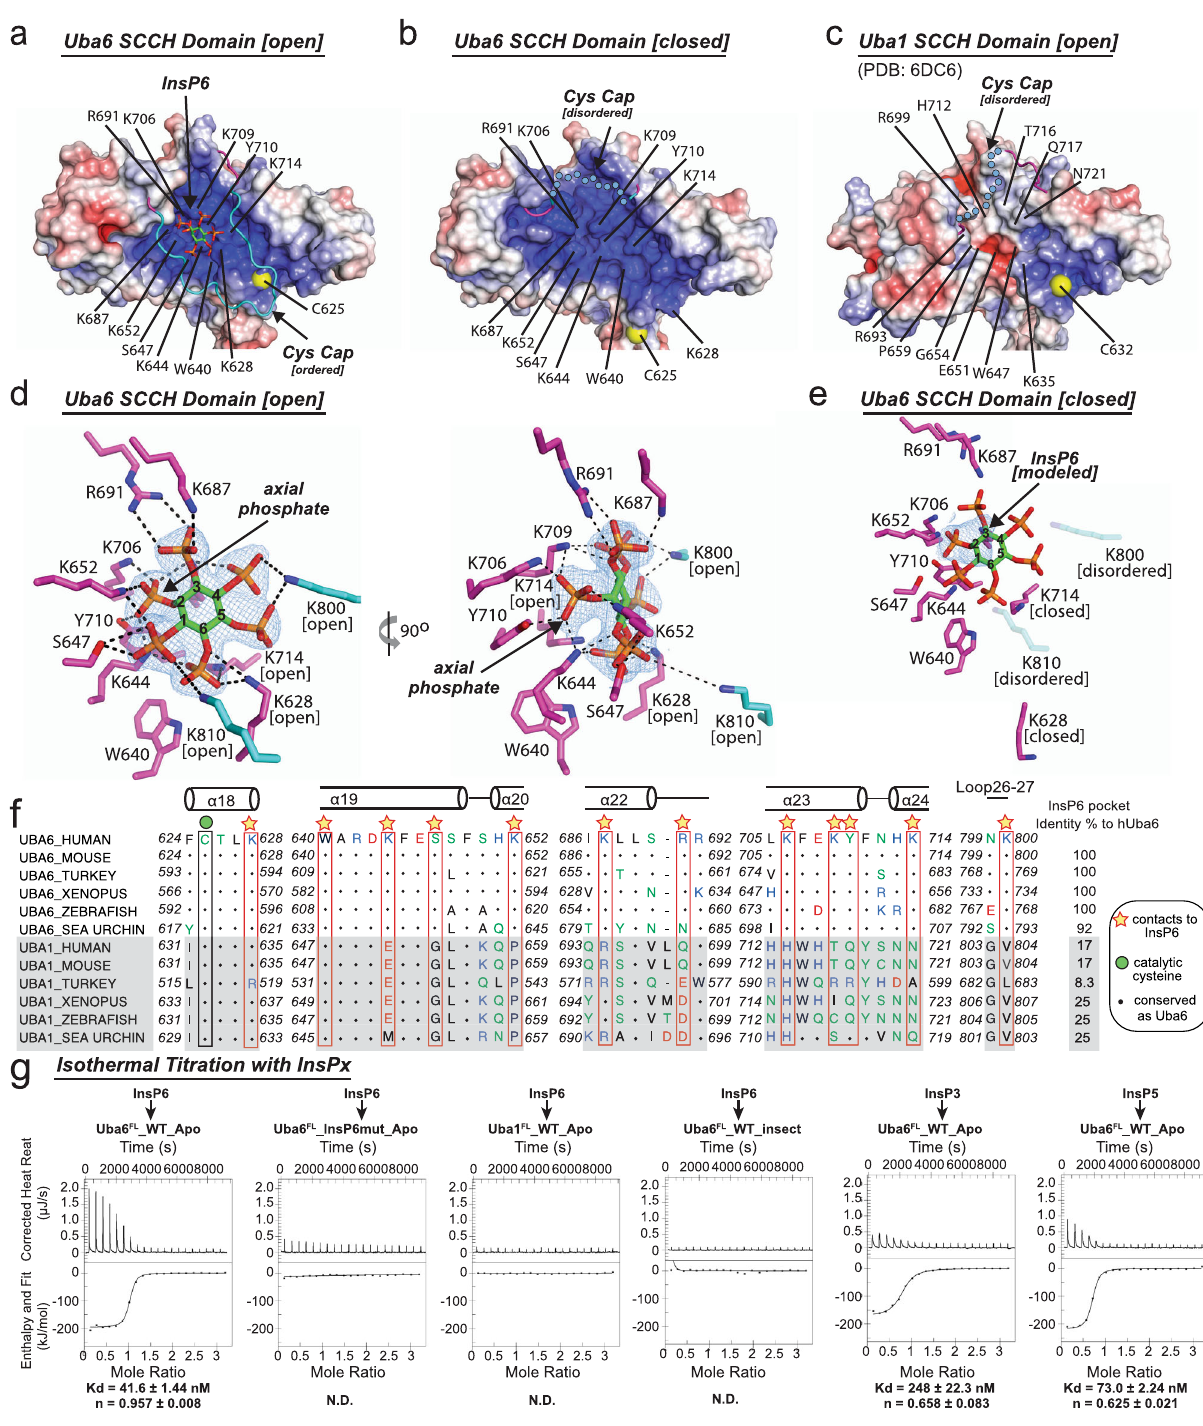
Fig. 3 | InsP6 binds to a highly basic pocket unique to the SCCH domain of Uba6. a – c Surface electrostatic representations of the SCCH domains of human Uba6 open ( a ) Uba6 closed ( b ) and Uba1 ( c ) structures. Uba6 residues involved in contactsto InsP6in theUba6openstructureand the correspondingresidues from the Uba6 closed and Uba1 structures are labeled. The ordered cys cap in the Uba6 openstructureisshownascartoonandcoloredcyanandthedisorderedcyscapsof Uba6closed and Uba1areshownasdashed cyancircles. d Compositeomitdensity map(contoured at 1 σ )forInsP6inthe Uba6open structureisshownasblue mesh. InsP6 isshown assticks with carbons (green),oxygens (red), phosphates (orange). InsP6-interacting residues are shown as sticks and hydrogen bonds are shown as